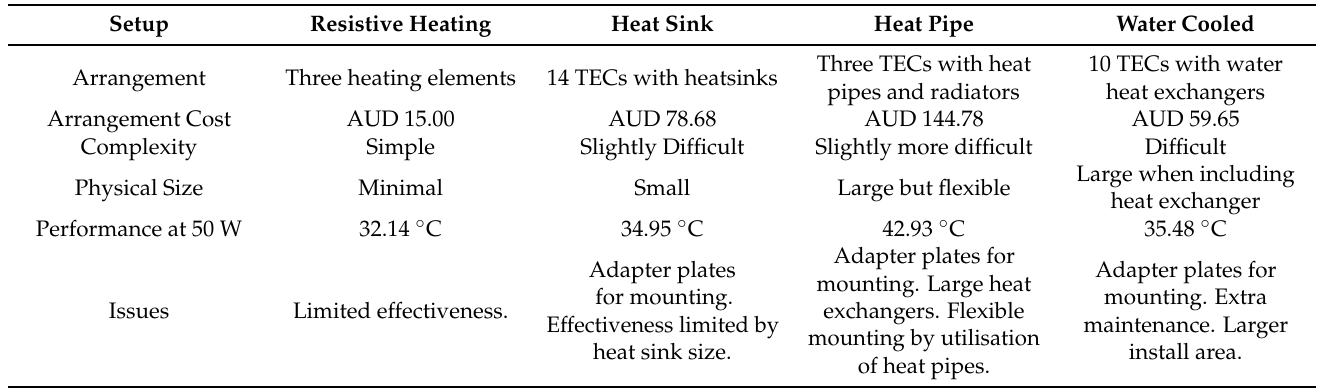
Figure 15. The graphed results of the heating with the TECs and water cooled heat sinks. At 50 W nominal input power, the inner core and winding slot temperatures for all the heating systems are summarised in Table 1. In addition, the slot temperatures at various input powers for all the heating systems are shown in Figure 16. Table 1. Comparison of the heating setups.